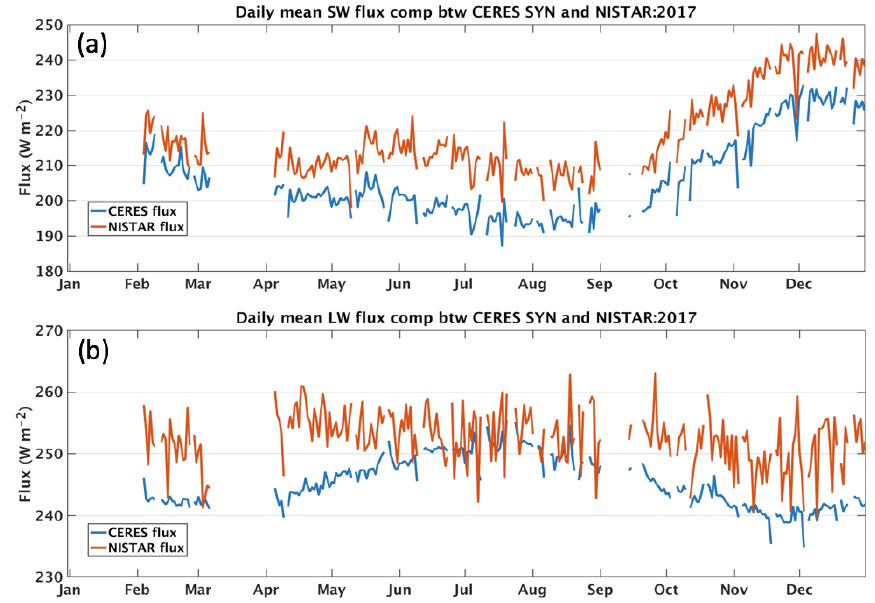
Figure 10. Daily mean SW flux (a) and LW flux (b) comparisons between CERES SYN1deg (blue) and NISTAR (red) for